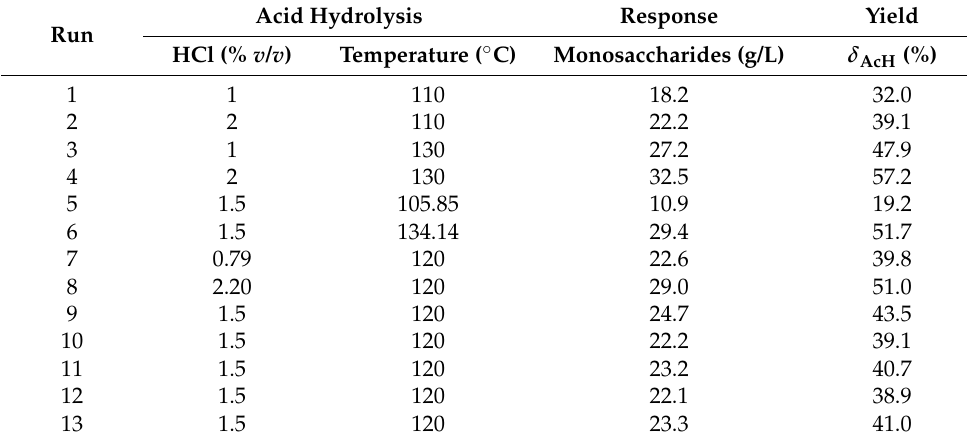
Table 2. Central composite design for acid hydrolysis, concentration of monosaccharides, and yield.